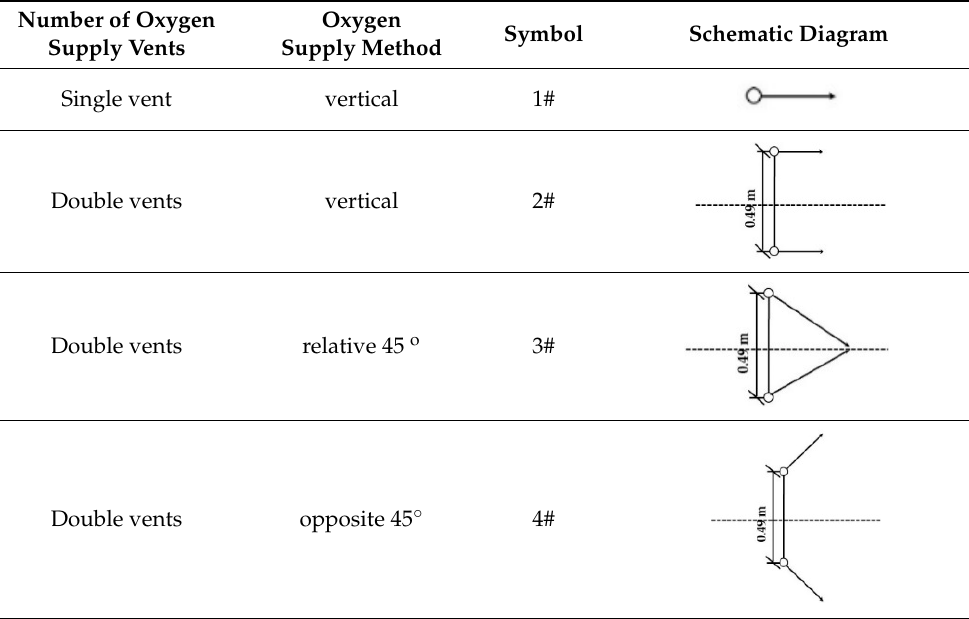
Table 3. Initial conditions of the oxygen supply parameters.